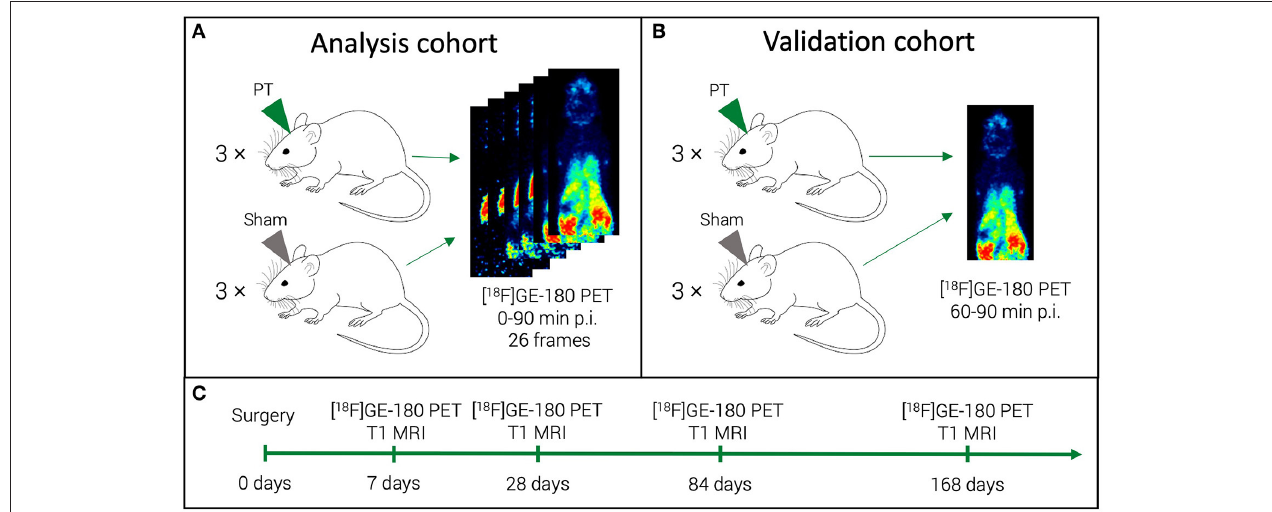
FIGURE 1 | Study mice and acquired scans. For a half of the study mice (analysis cohort), we performed a dynamic [ 18 F]GE-180 acquisition (A) . For the other half (validation cohort), a shorter scan was performed (B) . All the mice were scanned at four time points in a longitudinal design (C) .